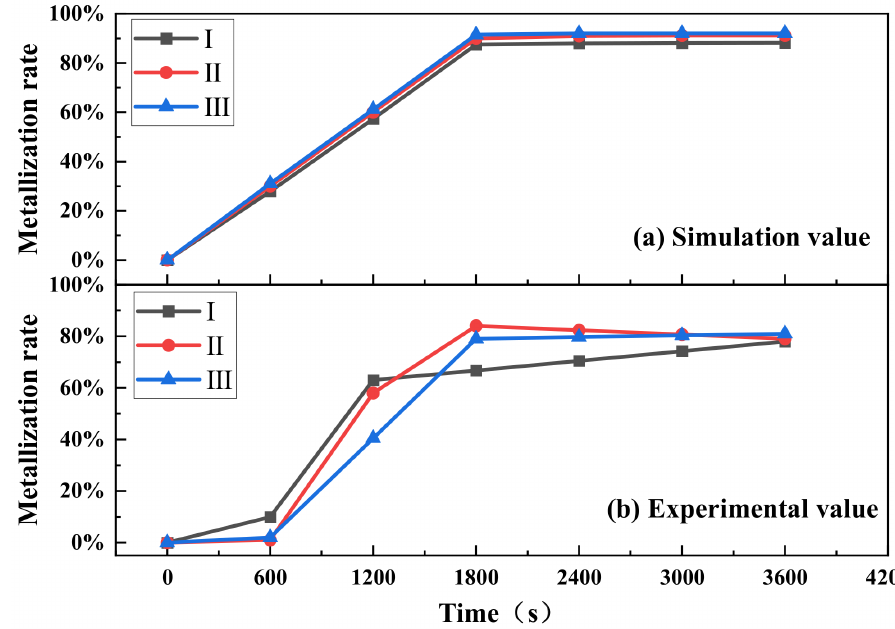
Figure 6. Metallization